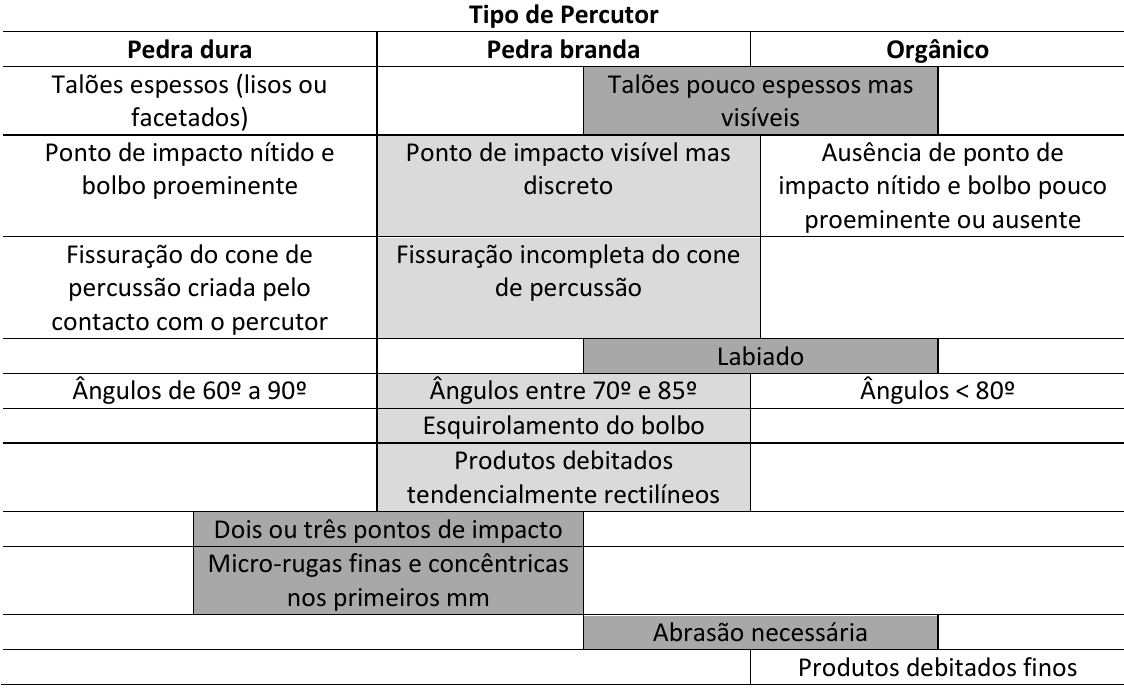
Tabela 1. Resumo dos estigmas diagnosticantes dos diferentes tipos de percutor, representando a cinzento escuro as características comuns à utilização de percutor em pedra dura e em pedra branda ou pedra branda e orgânico. Segundo os dados de talhe experimental apresentados por Texier et al. (1980), Inizan et al. (1995), J. Pelegrin Table 1. Summary of the diagnostic stigmata from different types of hammer, representing in dark grey overlapped characteristics to the use of hard hammerstone and soft hammerstone or soft hammerstone and organic hammer. According to the experimental data presented by Texier et al. (1980), Inizan et al. (1995), J. Pelegrin (2000), Valentin (2000) e Damlien